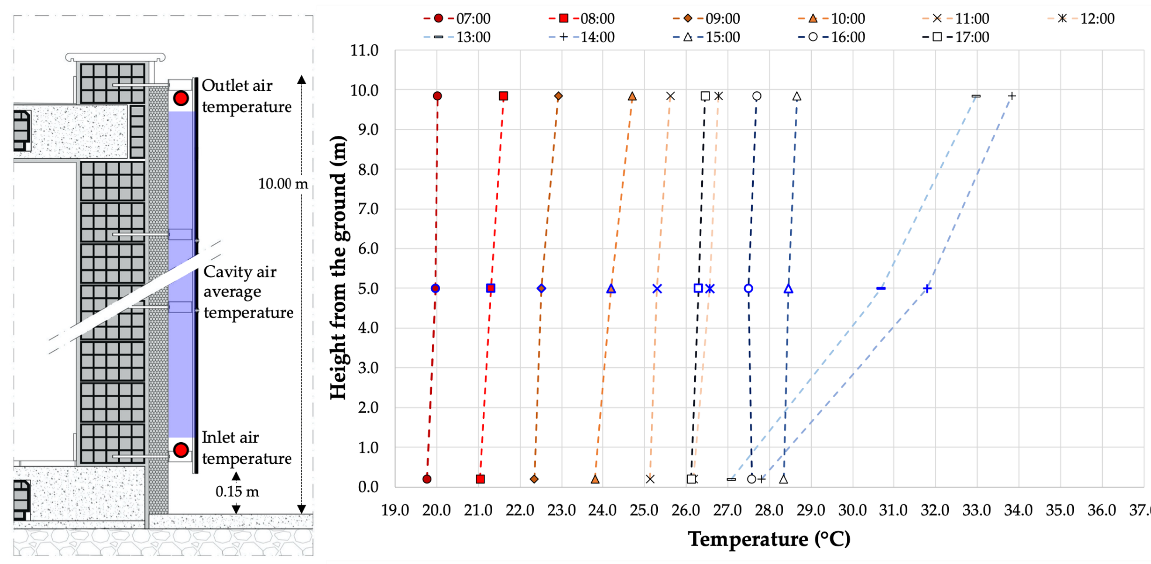
Figure 17. Simulated daily values of the cavity air temperature for a typical summer day.